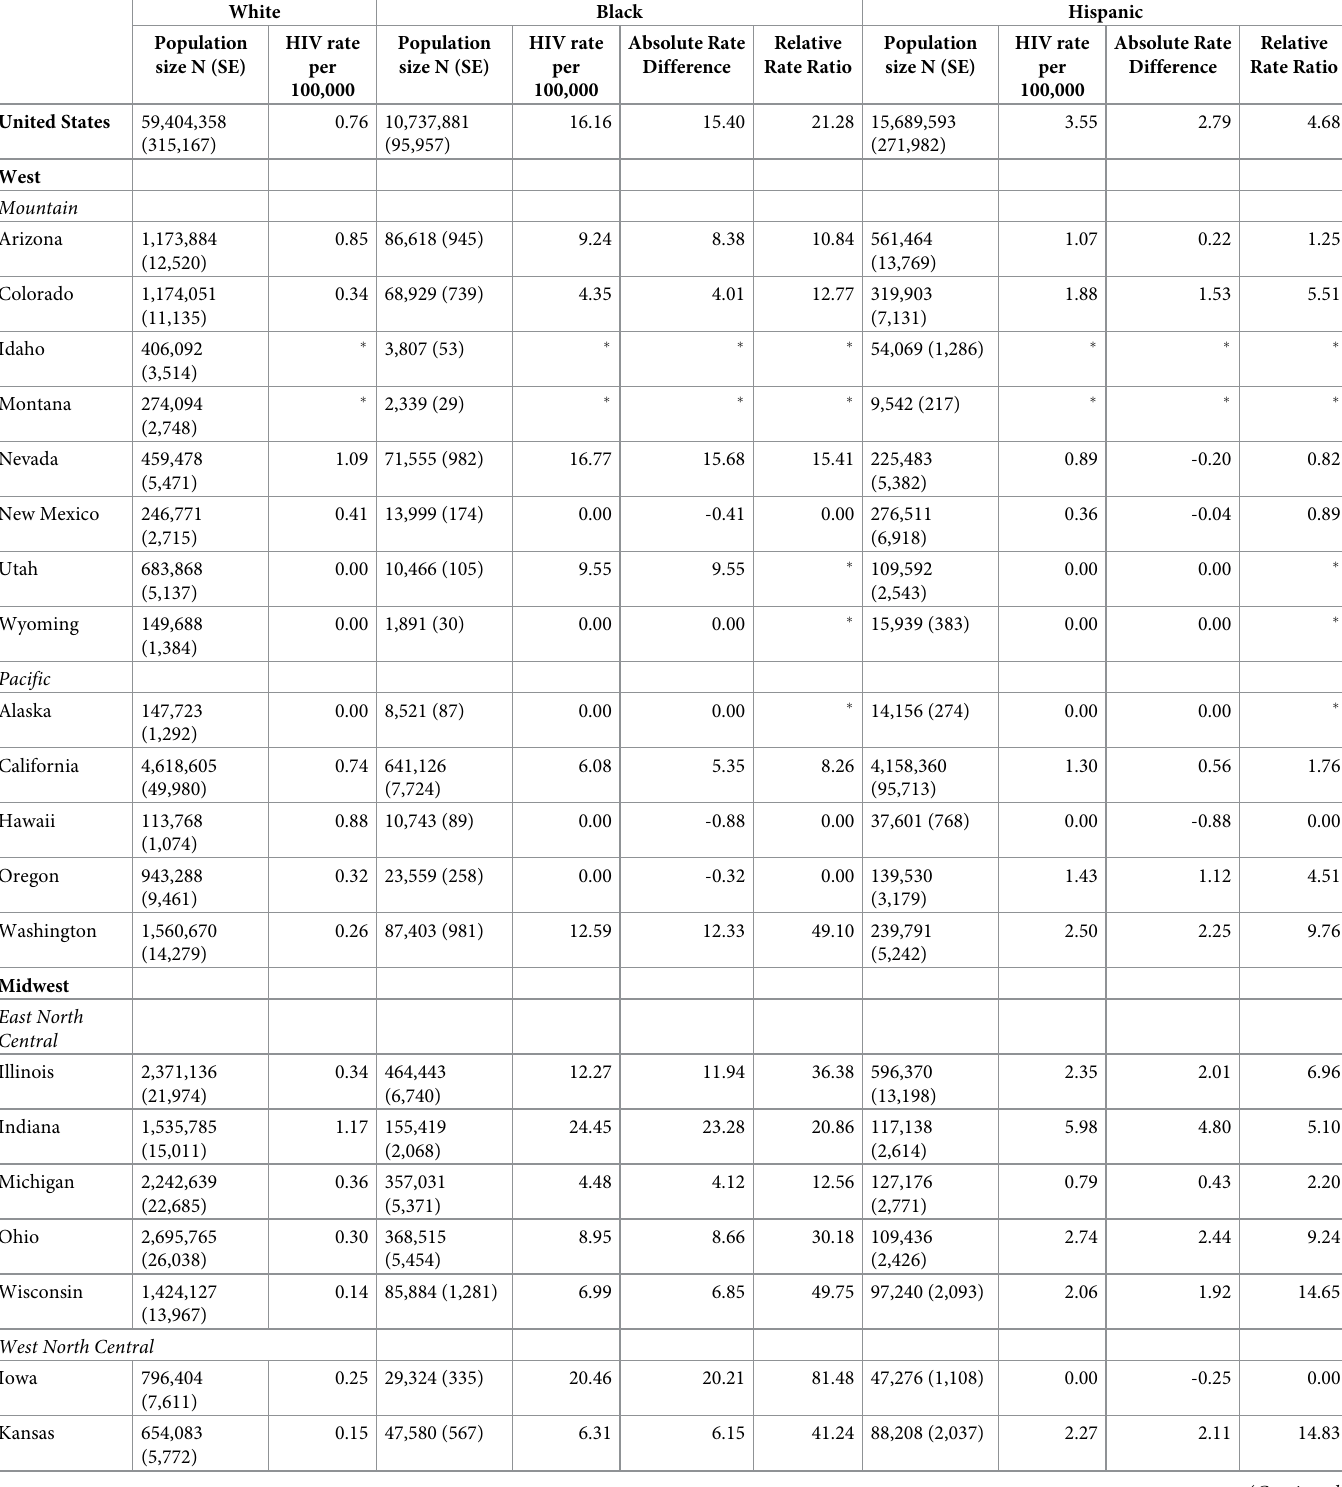
Table 1. State-level estimates of heterosexually active Men Ages 18+, HIV diagnosis rates, and disparity measures.